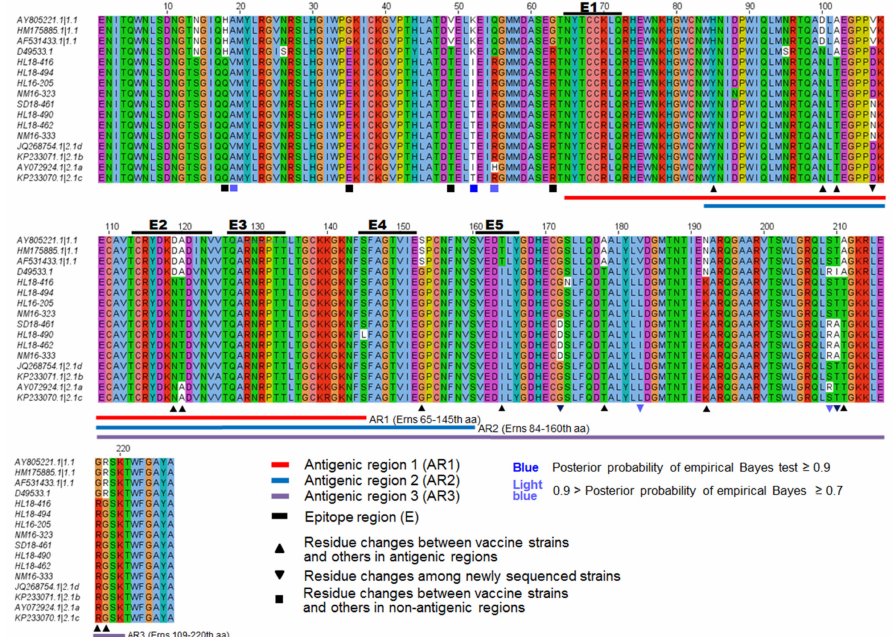
Figure 5. Sequence alignment of amino acids of E rns from 8 new CSFV strains isolated in our study, and 8 reference isolates downloaded from NCBI. Red, blue and purple lines indicate the antigenic regions AR1, AR2 and AR3, respectively. E rns protein residue changes between vaccine strains and others in antigenic regions are indicated by ( (cid:78) ) symbol, residue changes among newly sequenced strains are indicated by ( (cid:72) ) symbols and those between vaccine strains and others in non-antigenic regions are indicated by ( (cid:4) )